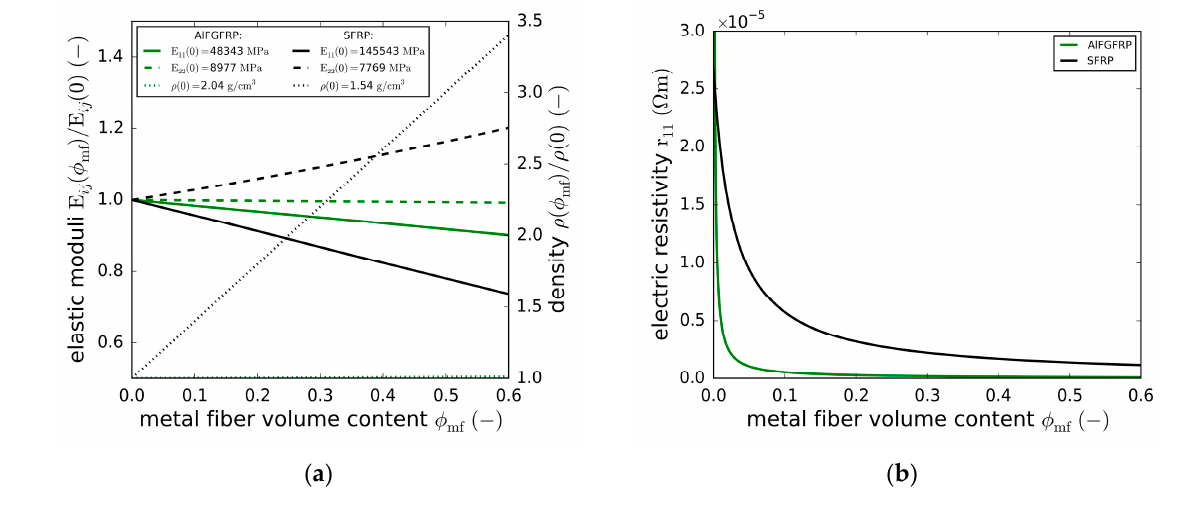
Figure 3. Properties of the AlFGFRP and SFRP for different metal volume fractions: ( a ) normalized elastic moduli and density; ( b ) electrical resistivity. Table 2. Properties of the constituent materials.